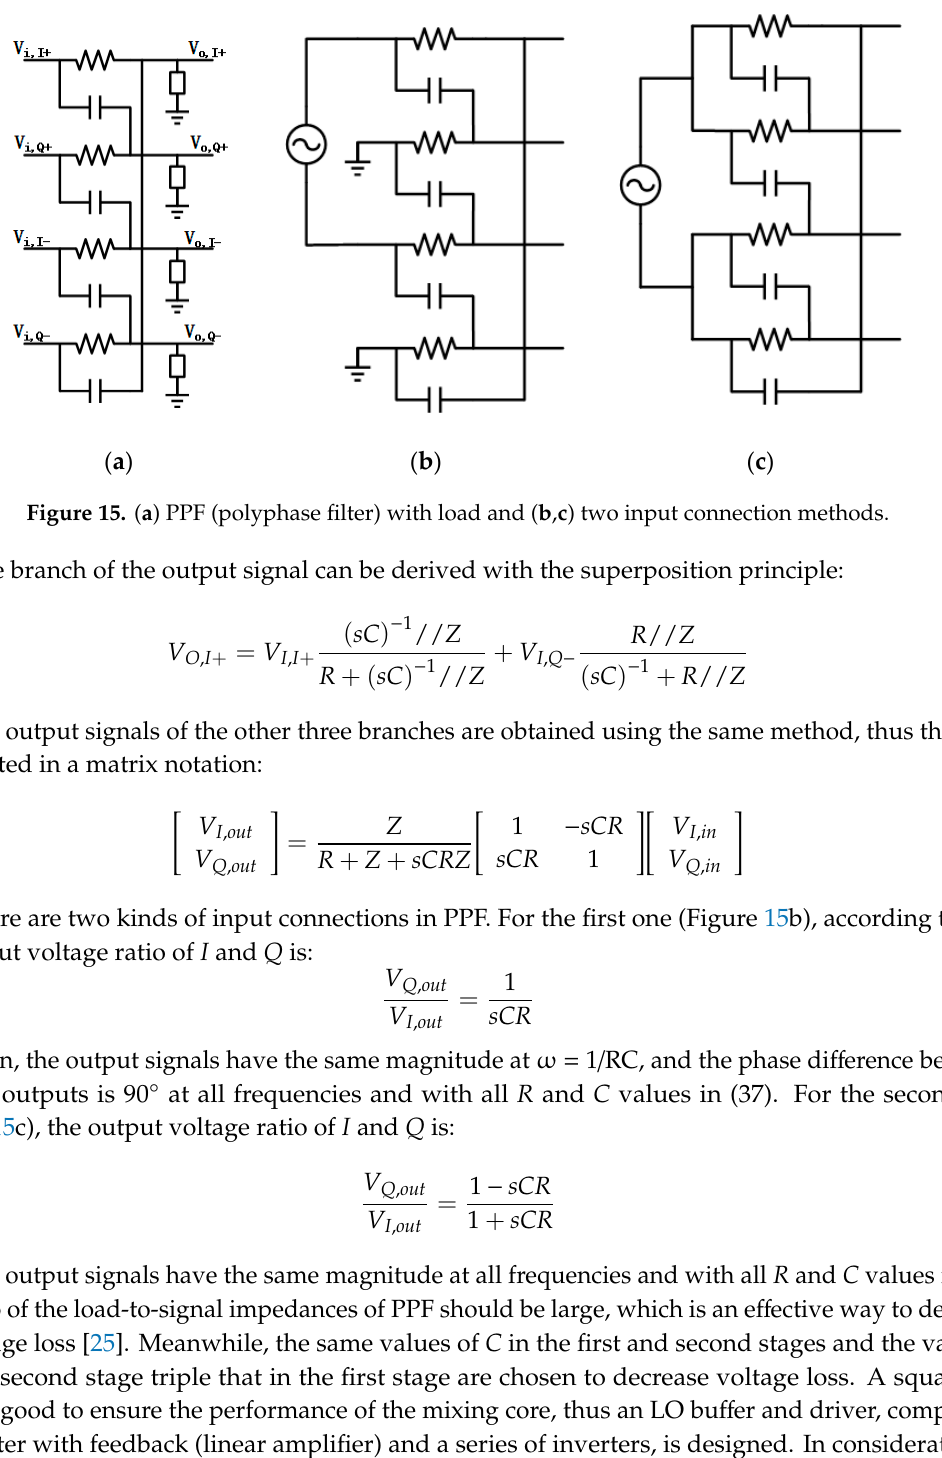
Figure 14. Schematic of the OTA (operational transconductance amplifier) and CMFB (common-mode feedback) circuit.